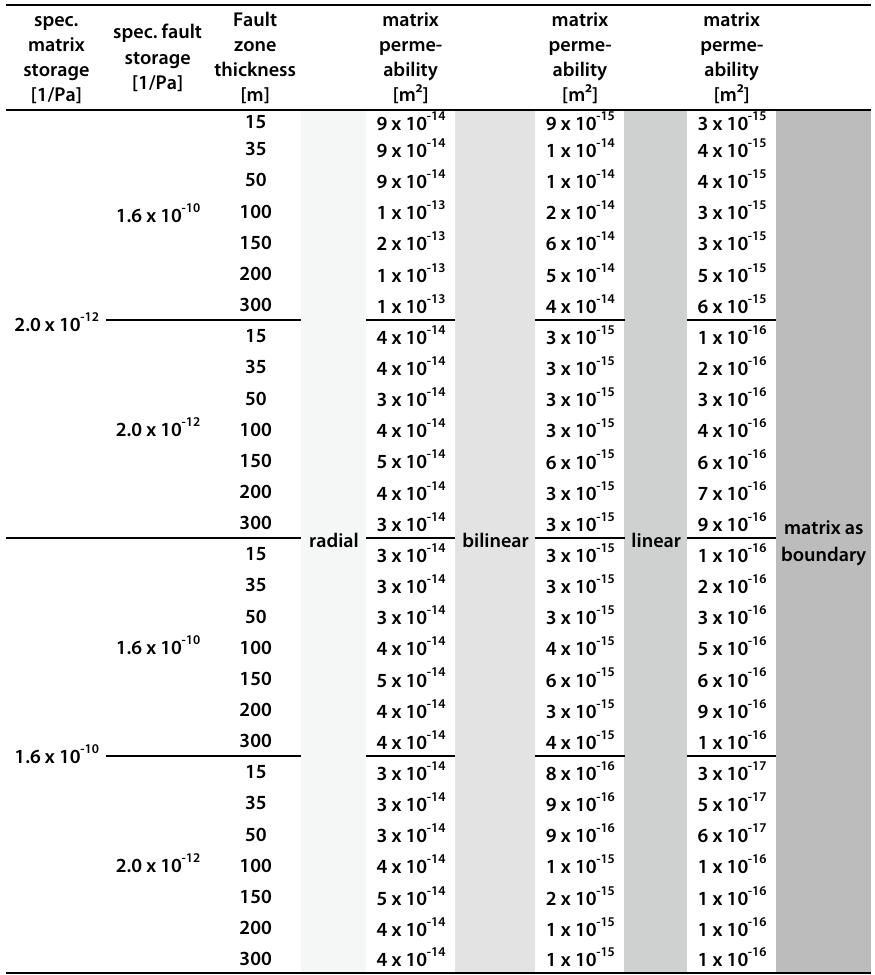
The table has been derived from the corresponding regression functions for minimum and maximum values of specific fault and matrix storage and for a fault permeability of 1.0e